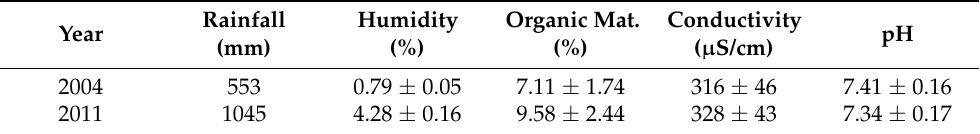
Table 1. Soil characteristics in two years of